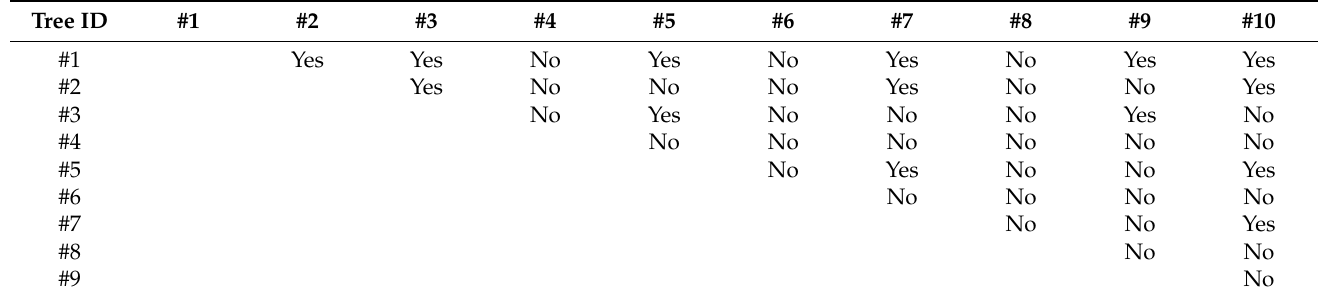
Table 2. Correlation of cone production between sampled trees at